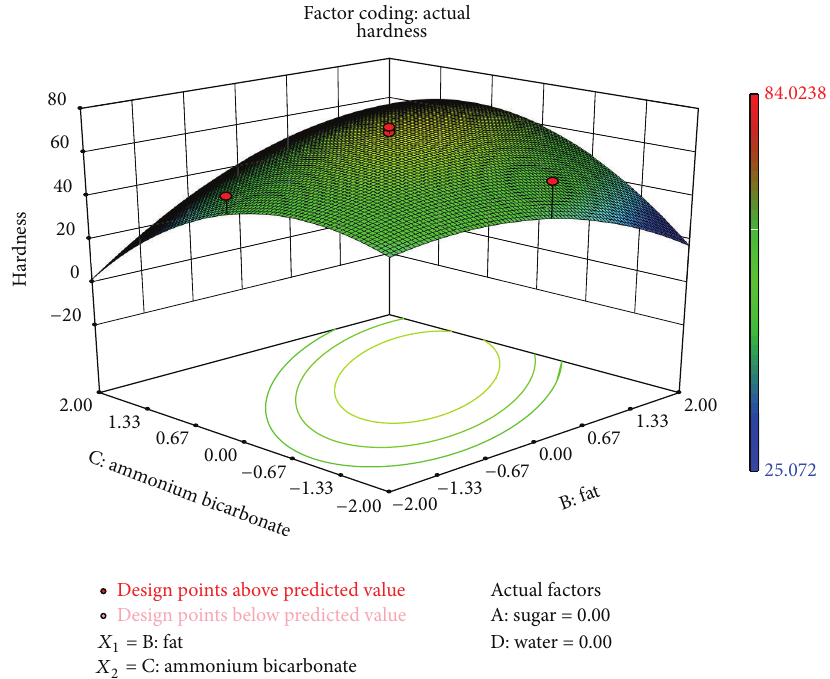
Figure 4: Surface plot representing the effect of fat ( 𝑋 2 ) and ammonium bicarbonate ( 𝑋 3 ) on hardness of the